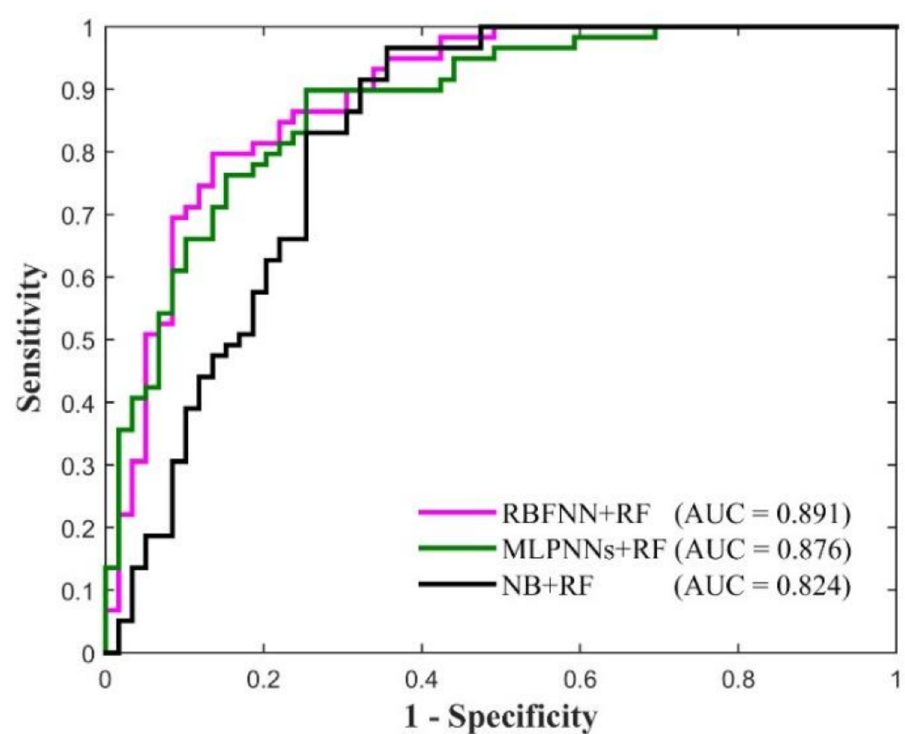
Figure 7. The ROC curves for different popular ensemble methods using the verification